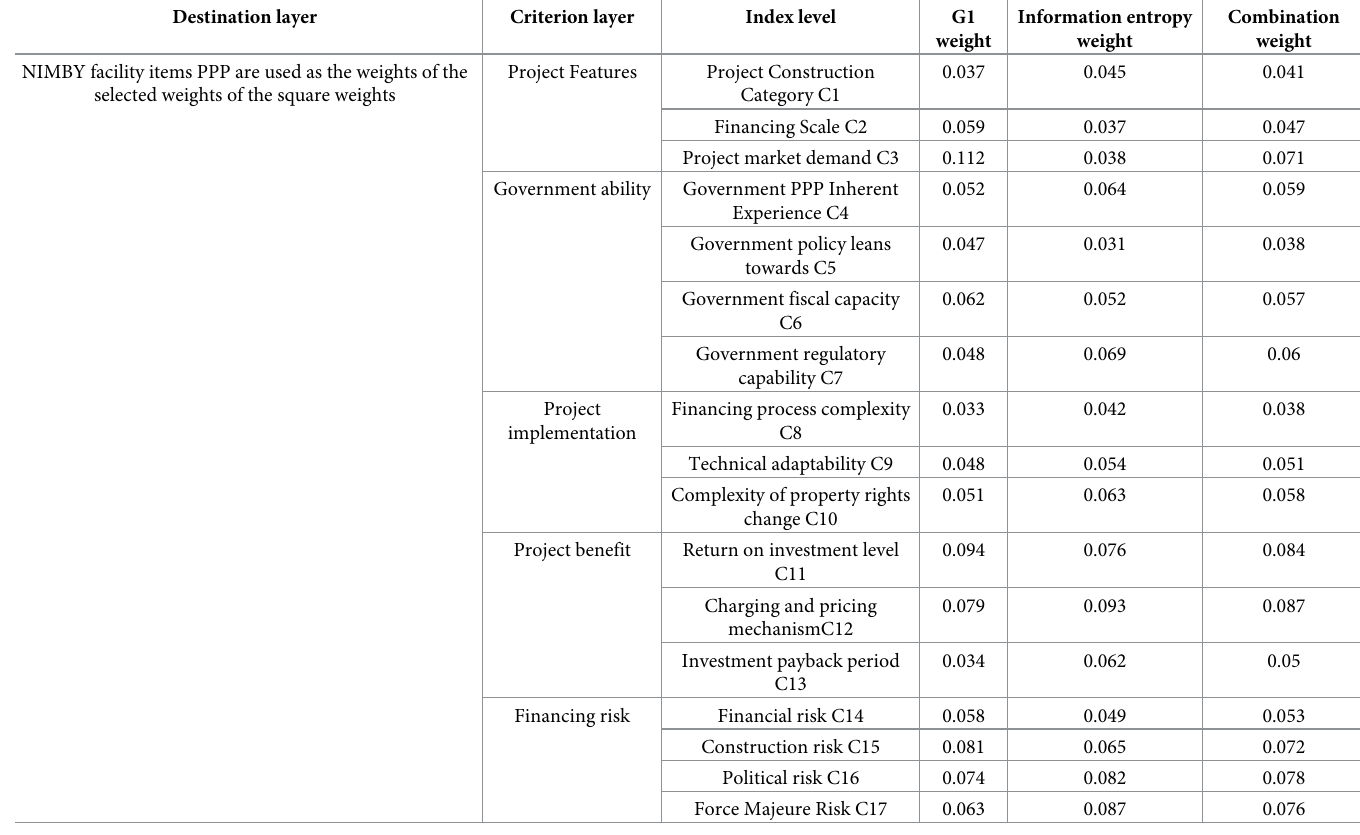
Table 4. NIMBY facility PPP project operation mode selection measurement index